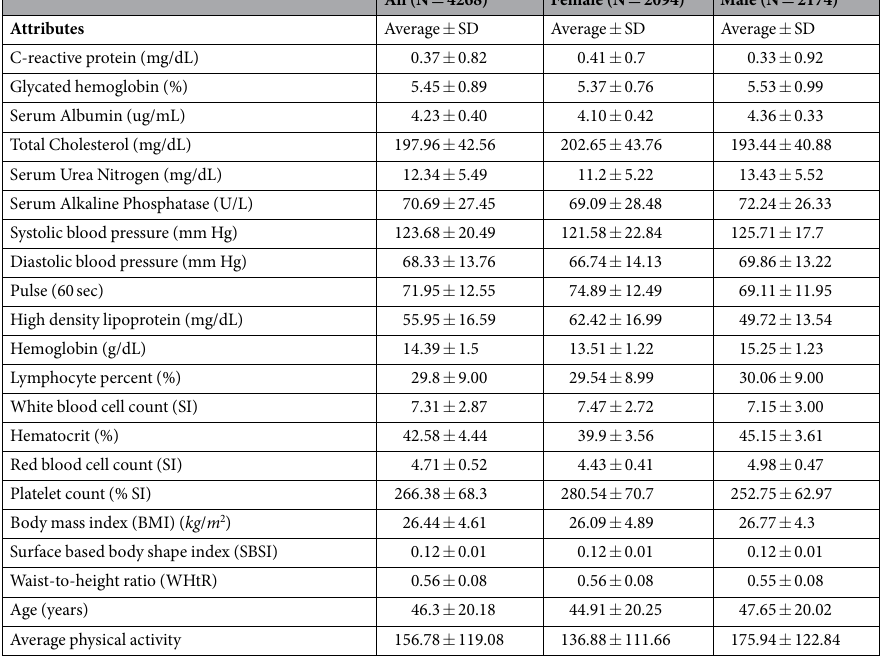
Table 1. Key attributes for study participants using the NHANES (2003–2006)